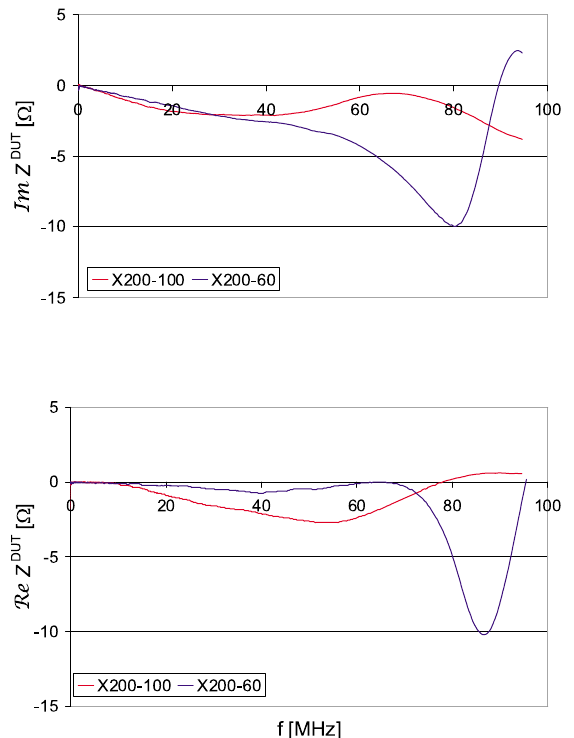
FIG. 5. (Color) Amplitude and phase of scattering coefficient in reference tube.